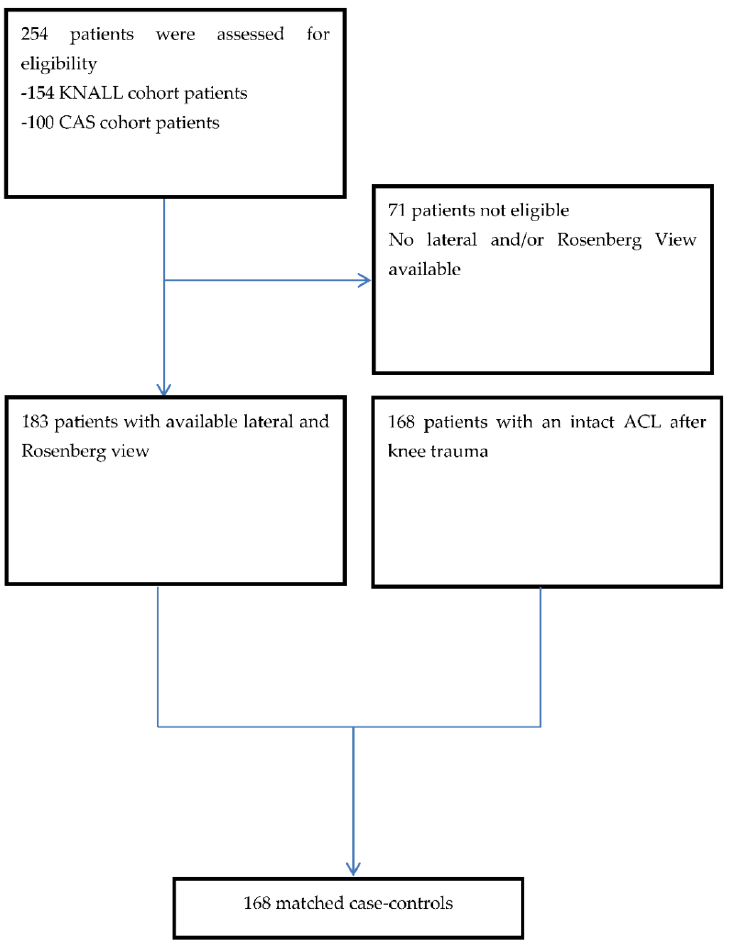
Figure 1. Flowchart of the selected patients included in the study. KNee osteoArthritis anterior cruciate Ligament Lesion (KNALL); Computer Assisted Surgery